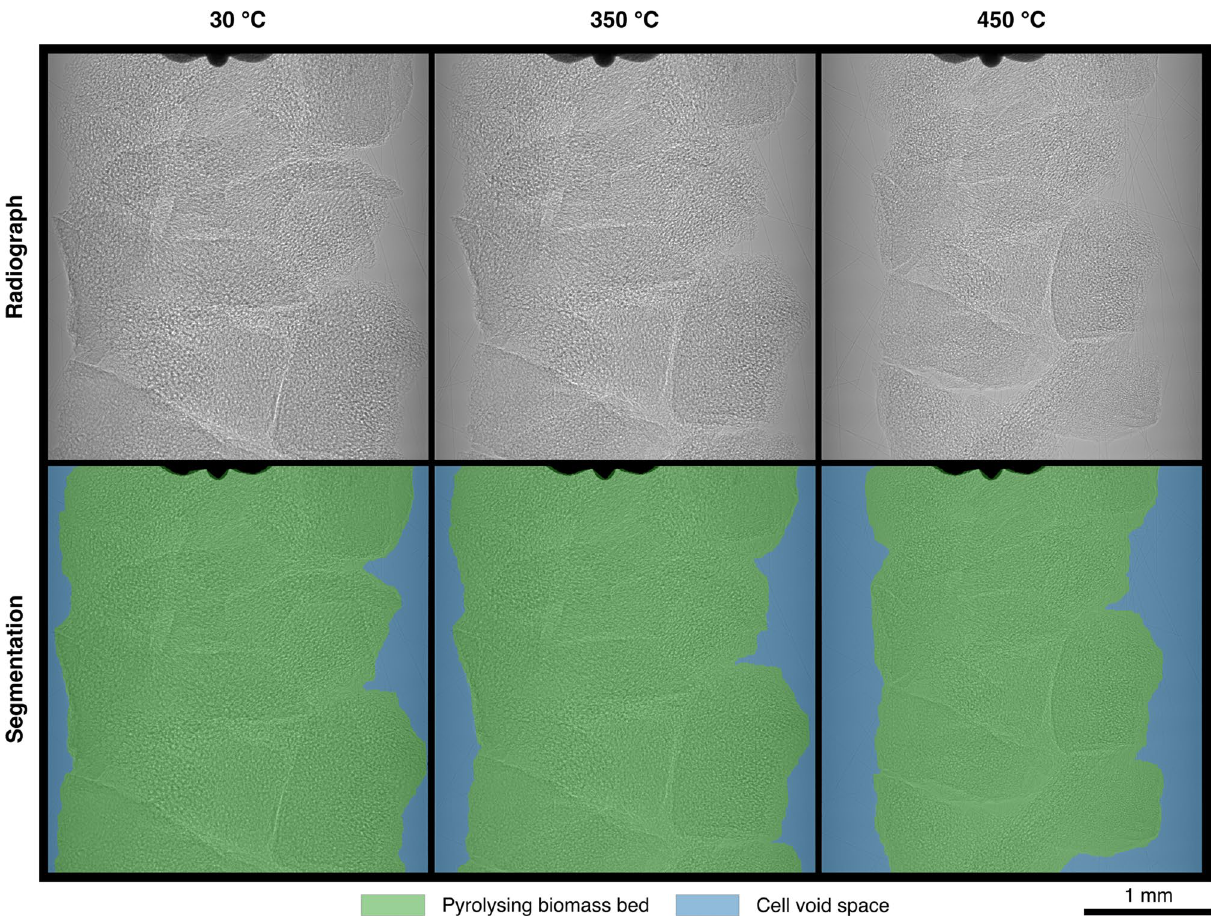
Figure 1. Radiographs and segmentations of a bed of water-soaked almond shells undergoing pyrolysis at a heating rate of 6 °C min −1 . Radiographs were acquired using a pink synchrotron X-ray beam (weighted mean energy ~ 27 keV) with effective pixel size of the detector set as 1.625 μm with an exposure time of 0.05